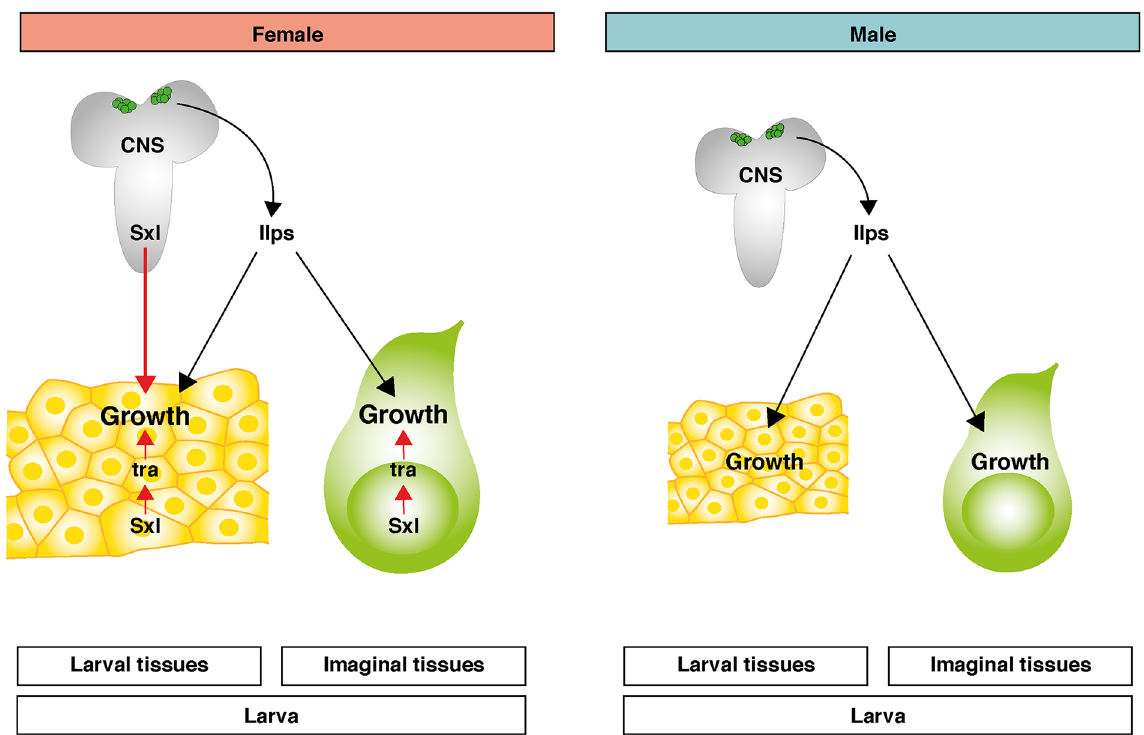
Fig 7. A relay model for the neuronal control of sexual size dimorphism (SSD) in Drosophila . Sex-lethal (Sxl) expressionin insulin-producing cells (IPCs) and other neuronsof the central nervoussystem (CNS) acts, largelyindependently of the female- specific tranformer splice variant (TraF), to relay a signal(s) to peripheral larval tissues. This signal specifies the female-specific growth trajectory of larval tissues and does not appearto involveIPC-derived insulin-likepeptides(Ilps) or insulinsignalling.Imaginal tissue growth duringlarval stages is insensitiveto the neuronalSxl signal. Sxl also acts cell-autonomously via TraF in both larval and imaginal tissues to increasefemale growth. Red arrows indicate female-specific regulation;black arrows indicatenon-sex-specific growth regulatorypathways. AdditionalSSD mechanismsnot depicted in this model are proposed in other studies